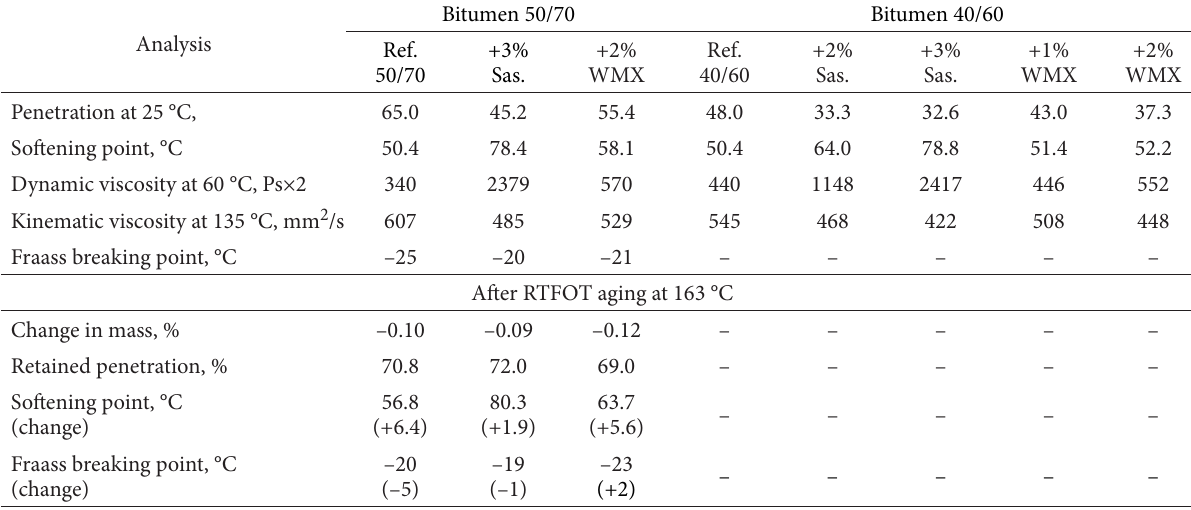
Table 1. Traditional bitumen test results